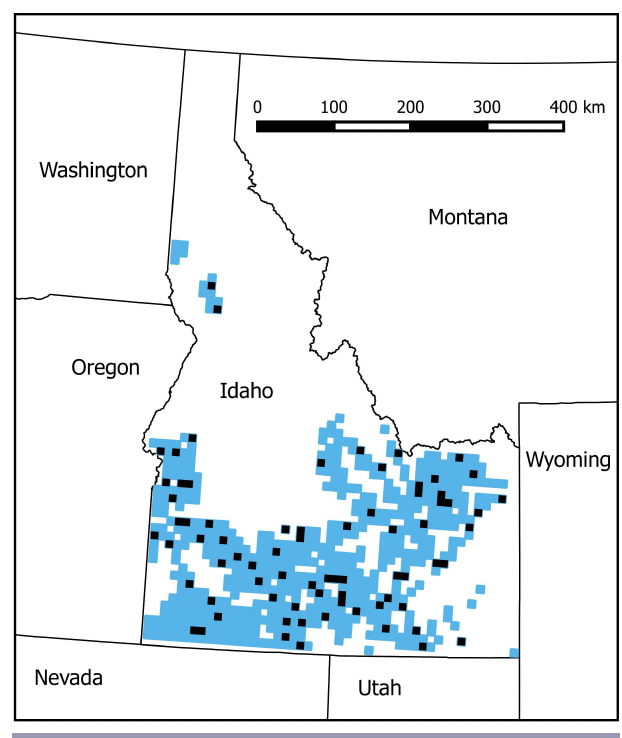
Fig. 2 . Distribution of strata (blue squares) and spatially balanced survey transects (black squares) for Short-eared Owl ( Asio flammeus ) surveys during the 2015 breeding season across the state of Idaho within the Intermountain West of the United